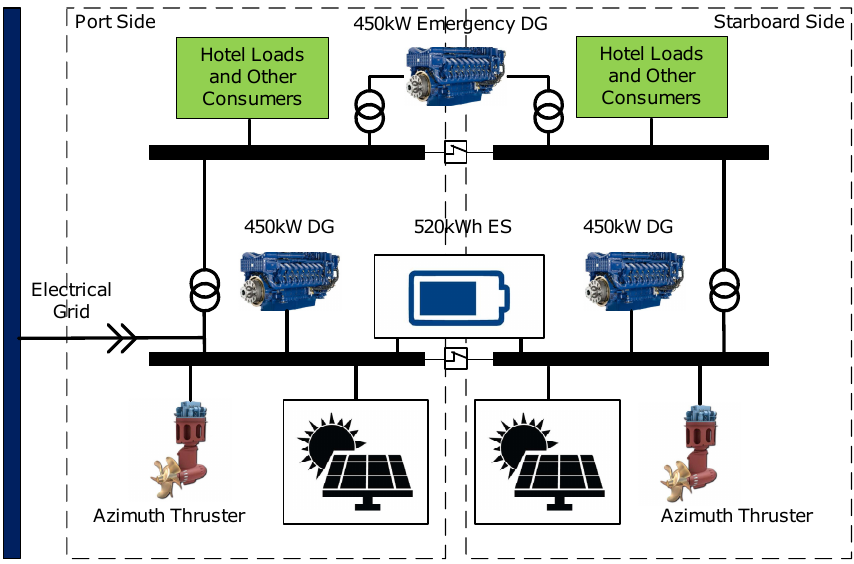
Figure 3. Single line diagram of hybrid-electric ferry with grid integration.